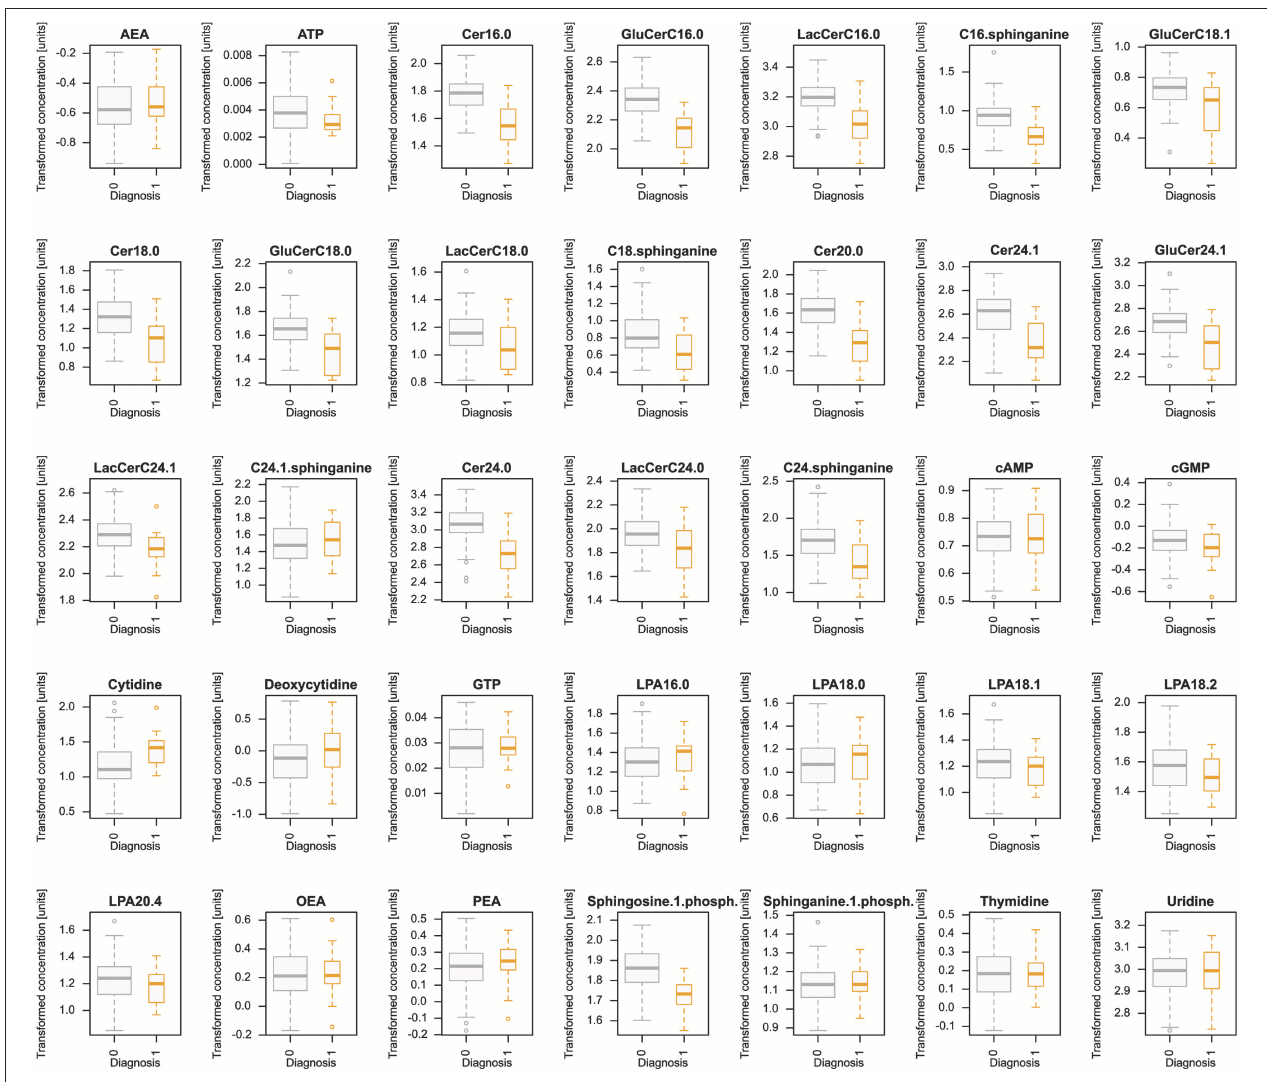
FIGURE 5 | Plasma concentrations of d = 35 lipid mediators (transformed and age corrected data) acquired from patients with dementia (yellow) or from patients with either bipolar disorder, depression ADHD or enrolled as healthy controls (gray). The data are shown in alphabetical order of lipid mediator names and for each mediator, separately for group membership to either or not the diagnosis of dementia (dementia = 1, others = 0). The widths of the boxes are proportional to the respective numbers of subjects per group. The quartiles and medians (solid horizontal line within the box) are used to construct a “box and whisker” plot. Single data are shown as dots. The whiskers add 1.5 times the interquartile range (IQR) to the 75th percentile or subtract 1.5 times the IQR from the 25th percentile and are expected to include 99.3% of the data if normally distributed. The figure has been created using the R software package [version 3.4.4 for Linux; http://CRAN.R-project.org/;